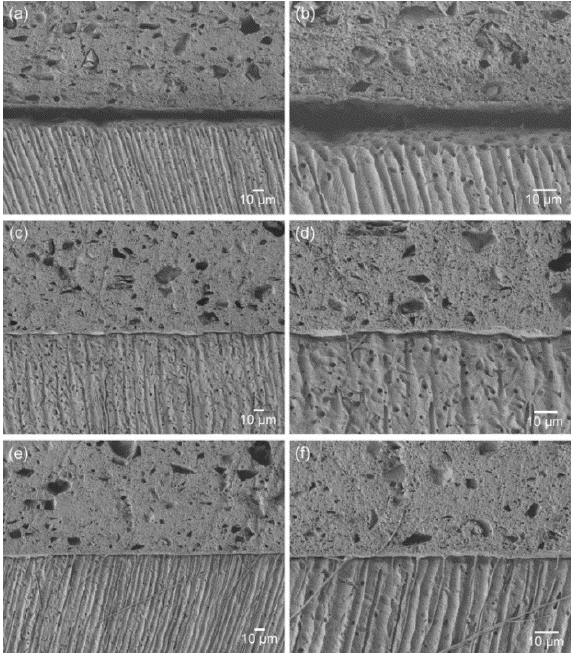
Figure 2. SEM images of the material-dentin interfaces: ( a ), ( b ) TL0; ( c ), ( d ) TL5; and ( e ), ( f ) TL10 ( a ), ( c ) and ( e ), ×450; ( b ), ( d ) and ( f ): ×1000).